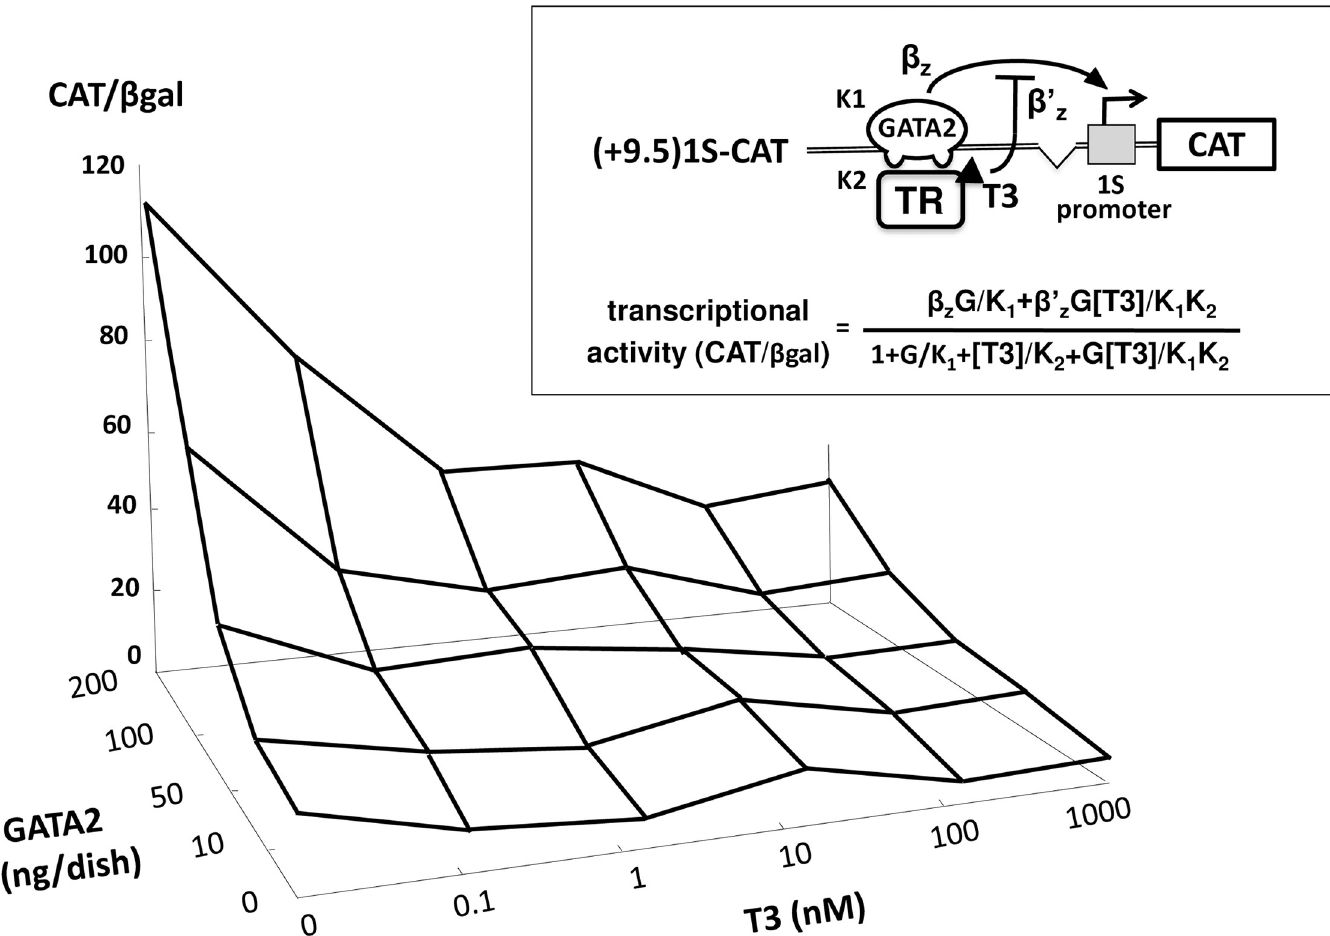
Fig 3. The liganded TR β 2 functions as a classical transcriptional repressor defined according to multi-dimensional input function theory. (+9.5)1S-CAT was transfected into CV1 cells along with the expression plasmid for TR β 2 (0.2 μ g) and various amounts of that for GATA2 (0 to 200 ng/dish) and treated with various concentrations of T3 (0 to 1000 nM). The data are plotted as a 3-dimesional graph. Results indicate that the liganded TR β 2 tethered to GATA2 Zn-finger functions as a classical transcriptional repressor (inset). The concentration of T3 ([T3]) represents that of liganded TR β 2. Using the data in (A) and the formula for multi-dimensional input function theory (inset) proposed by Alon [49], we calculated the DNA association affinity of GATA2 (K1), liganded TR β 2 (represented as [T3], K2), production rate of the promoter ( β z) and basal transcriptional activity (leakage) of the promoter ( β ’z) as 0.809, 0.081, 544.33 and 129.32, respectively. G, amount of the expression plasmid for